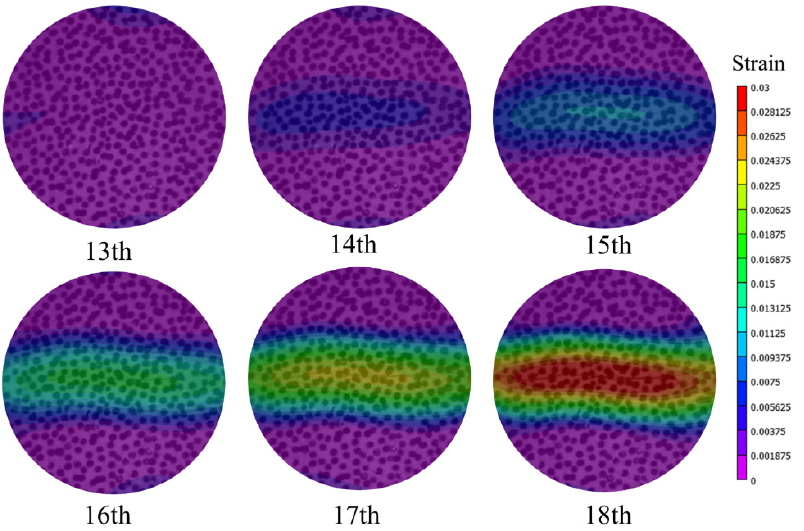
Figure 10. Strain variation diagram of concrete specimen with a turning point in the load–time curve.